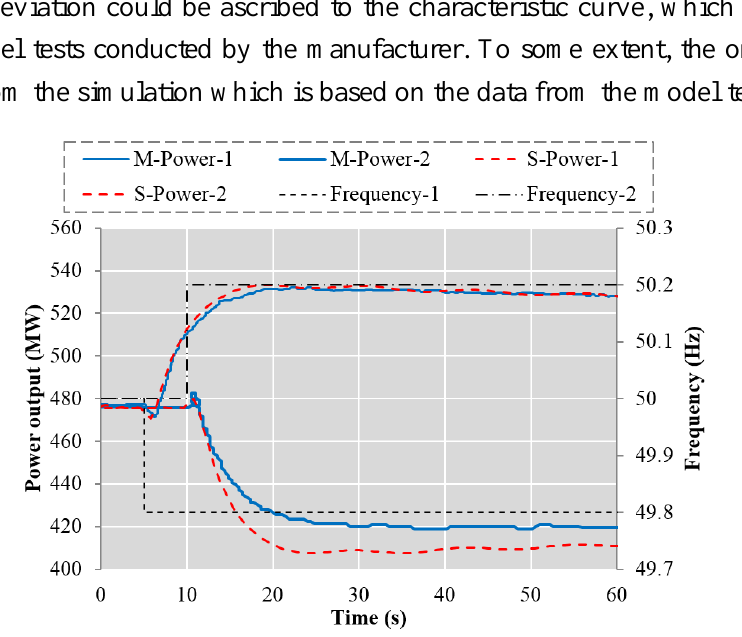
Figure 7. Power from simulation and measurement under step frequency input (Case 2).